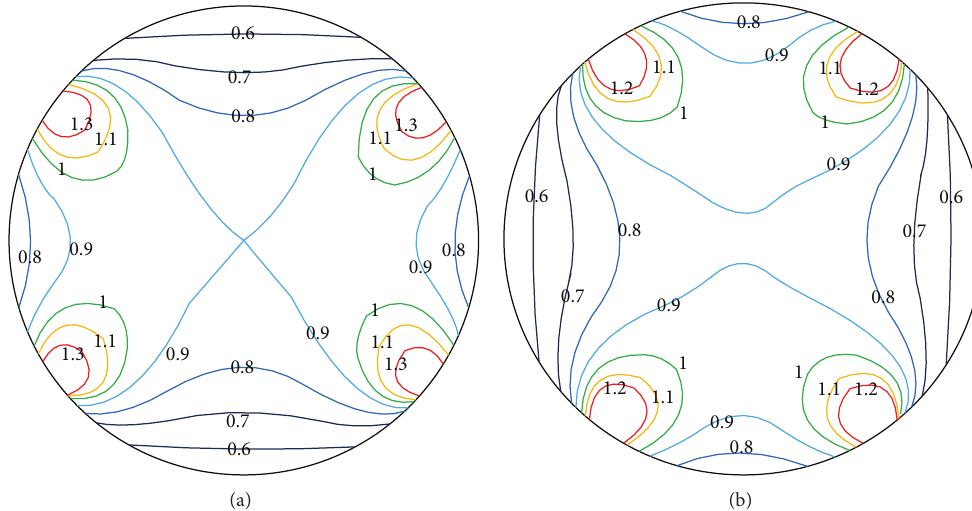
Figure 4: (a)-(b) The solutions of the weight function for EMFs with long-arc electrodes using resistive network